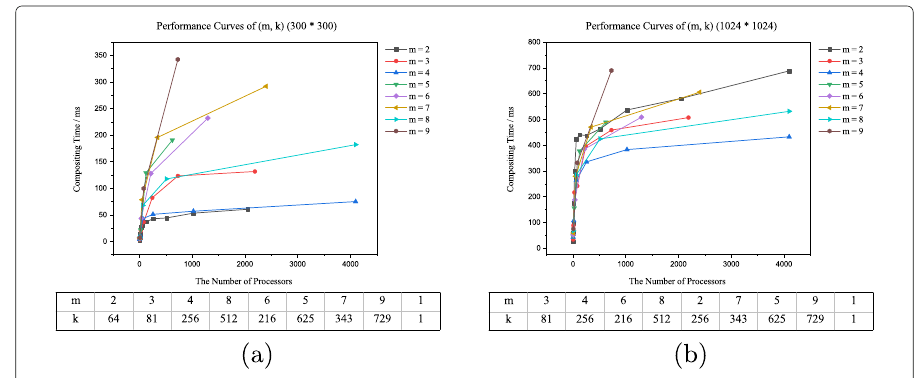
Fig. 6 Performance curves of ( m , k ) with a resolution of 300 ∗ 300 and 1024 ∗ 1024. The performance curves of ( m , k ) are used to locate the best point of m-ary tree. With the number of processors